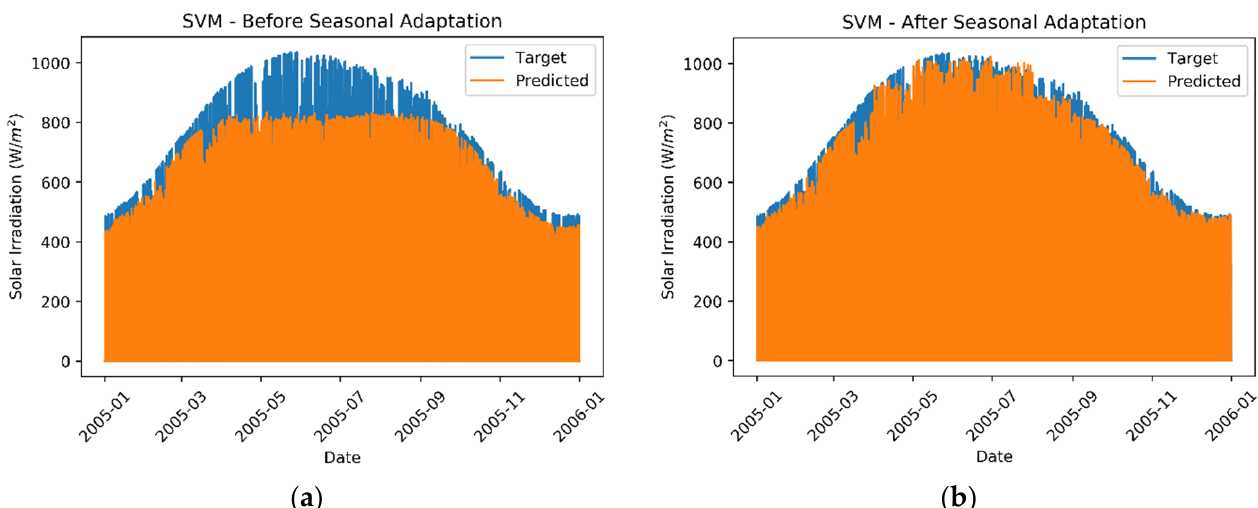
Figure 10. SVM ( a ) before and ( b ) after seasonal adaptation. For FBP, the improvement on the model with additional features was marginal. As version 1 (using the mean as the average) led to improvements for all metrics, it was chosen for the FBP model. Interestingly, applying the seasonal adaptation to the FBP model without the extraterrestrial radiation led to results in R 2 , MAE, and RMSE that were only slightly different from the model with extraterrestrial radiation. The seasonal adaptation had a greater positive impact on the model without extraterrestrial radiation, as shown in larger because the yearly and daily seasonality were both corrected, while for the model without extraterrestrial radiation could be considered if these data are not available. Table 6. Comparison of influence on seasonal adaptation on FBP models with different